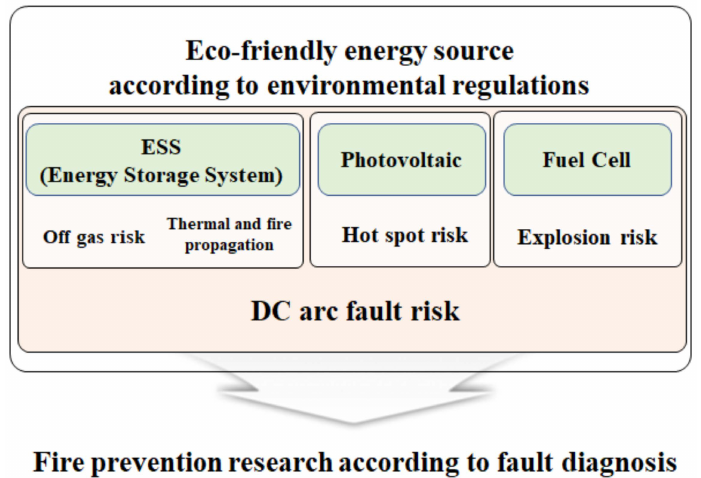
Figure 9. Research trends for fire prevention in next-generation power